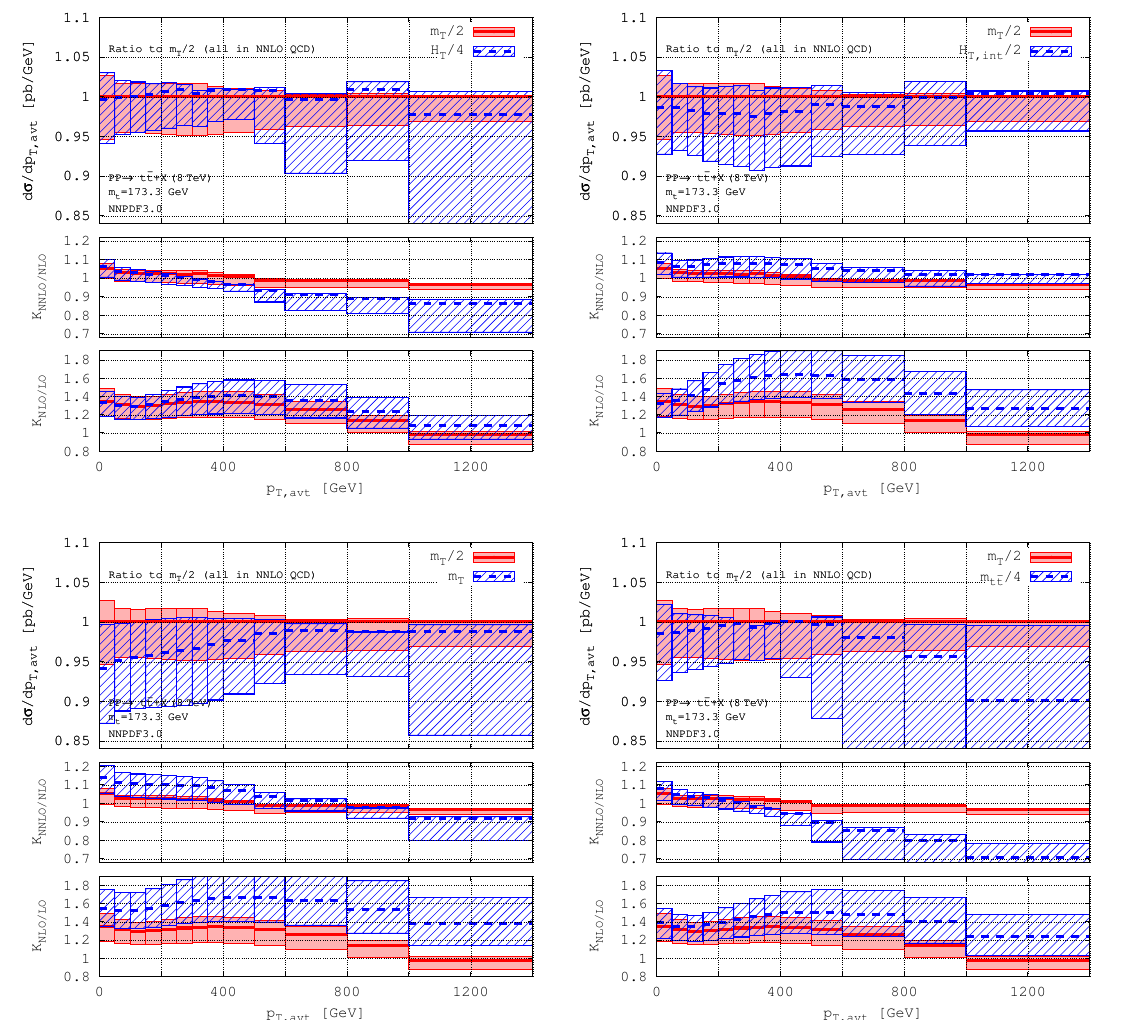
Figure 5 . Comparison of the average top/antitop p T di(cid:11)erential cross-section at NNLO evaluated with (cid:12)ve di(cid:11)erent dynamic scales. All plots show ratios with respect to the default scale m T = 2 (3.9): H T = 4 (top left), H T; int = 2 (top right), m T (bottom left) and m from scale variation